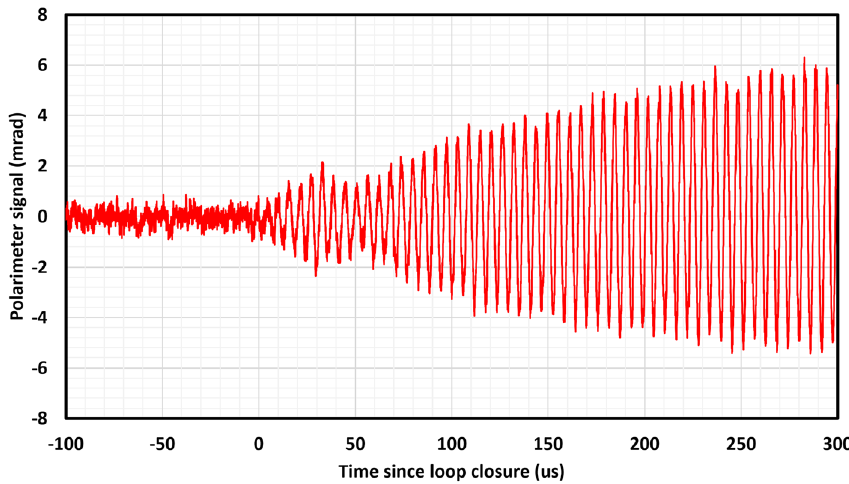
Figure 2. Digital spin maser signal response following closure of feedback loop at t = 0 s in a static B 0 field of 50 µ T .